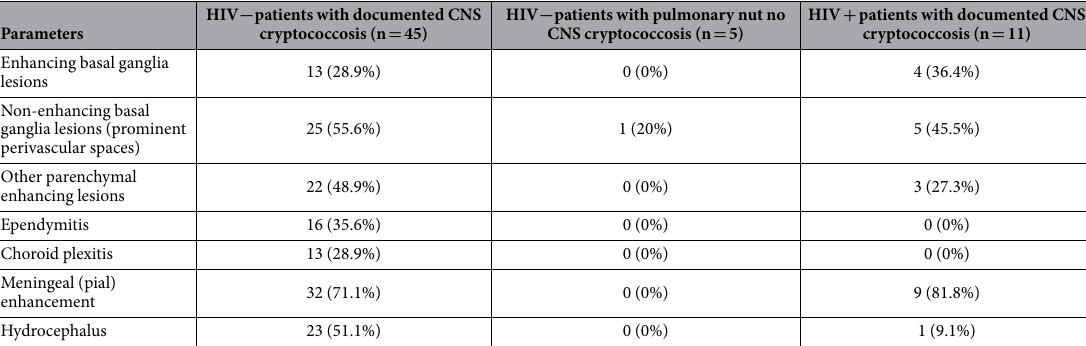
Table 2. Summary of Imaging Findings in HIV − and HIV + subjects.